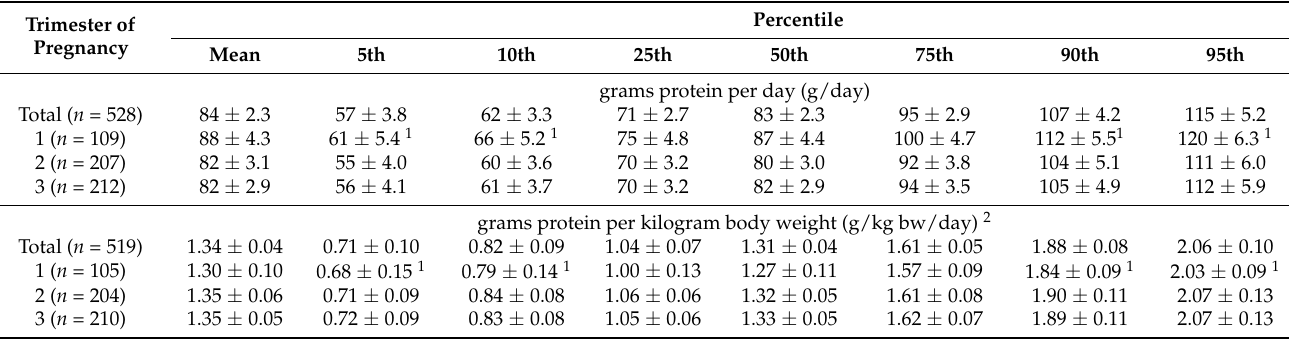
Table 2. Usual protein intake among pregnant women ages 20–44 years in 2003–2012 National Health and Nutrition Examination Survey.